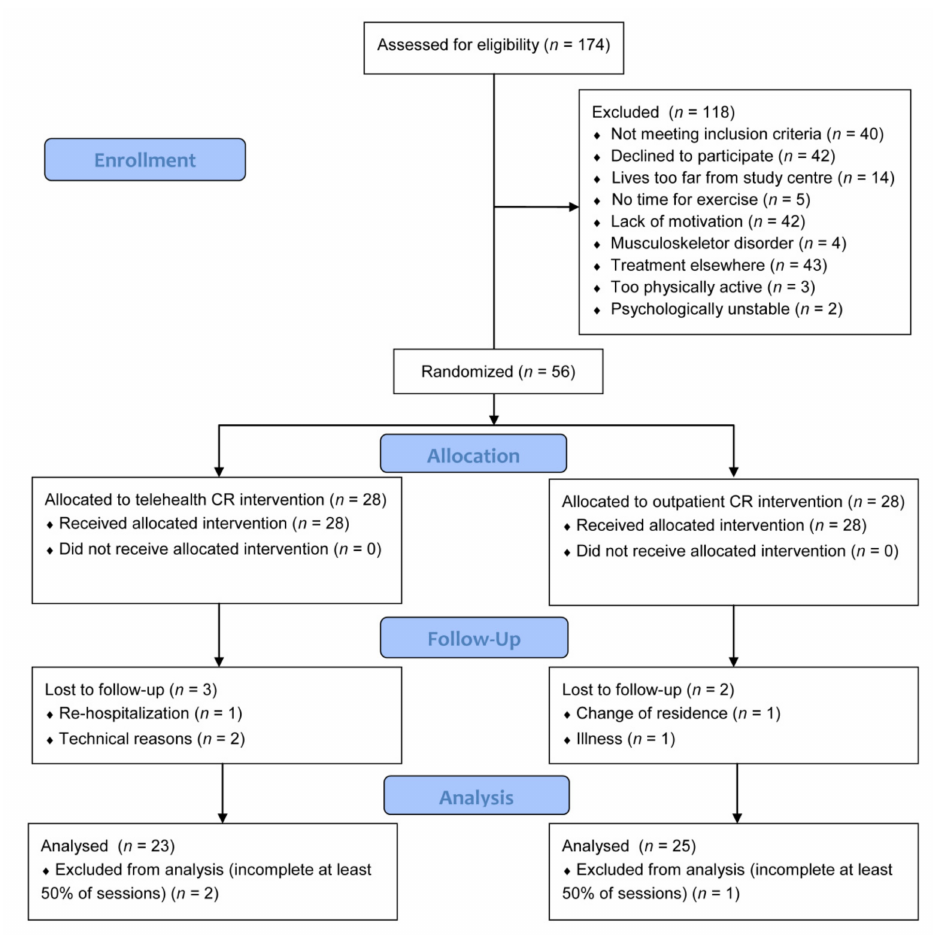
Figure 1. Study flow